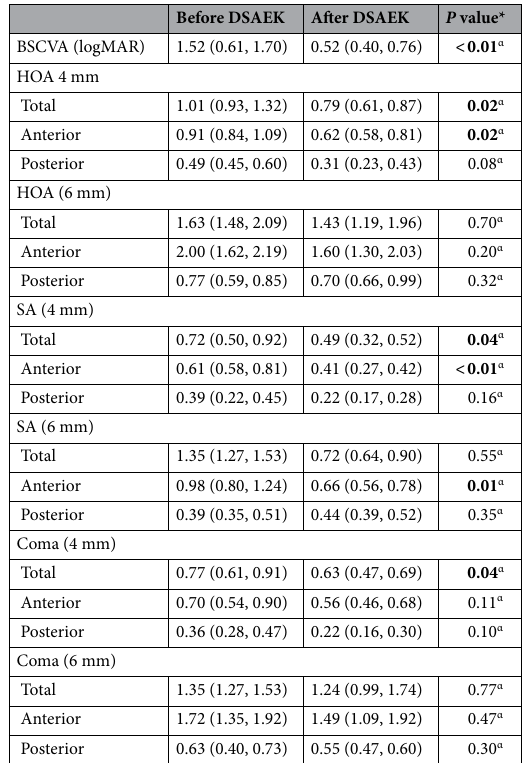
Table 4. Corneal higher-order aberrations before and after DSAEK in eyes with bullous keratopathy due to forceps corneal injuries. Data is shown by median (IQR) μm in 11 patients who underwent DSAEK. BSCVA, best-spectacle corrected visual acuity; DSAEK, Descemet stripping automated endothelial keratoplasty; IQR, interquartile range; logMAR, logarithm of minimal angle resolution; SA, spherical aberration. α P values: Mann–Whitney test. Bold numbers indicate P <